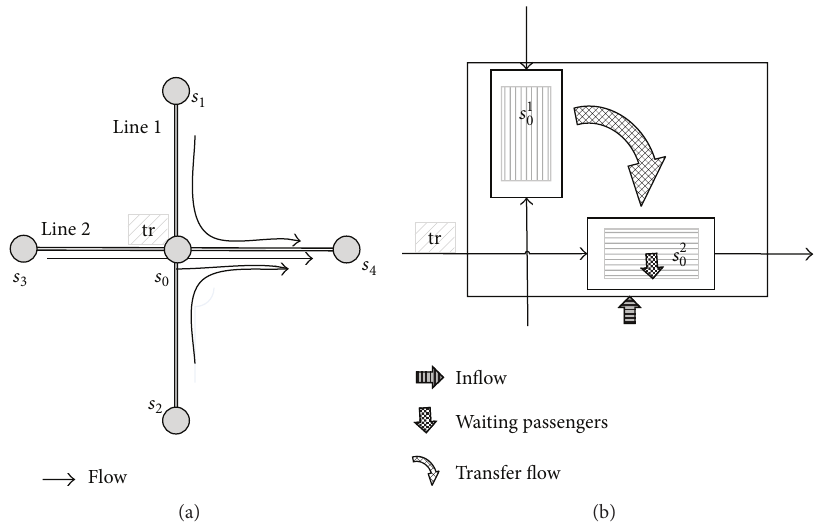
Figure 1: Compositions of waiting passengers in transfer station.